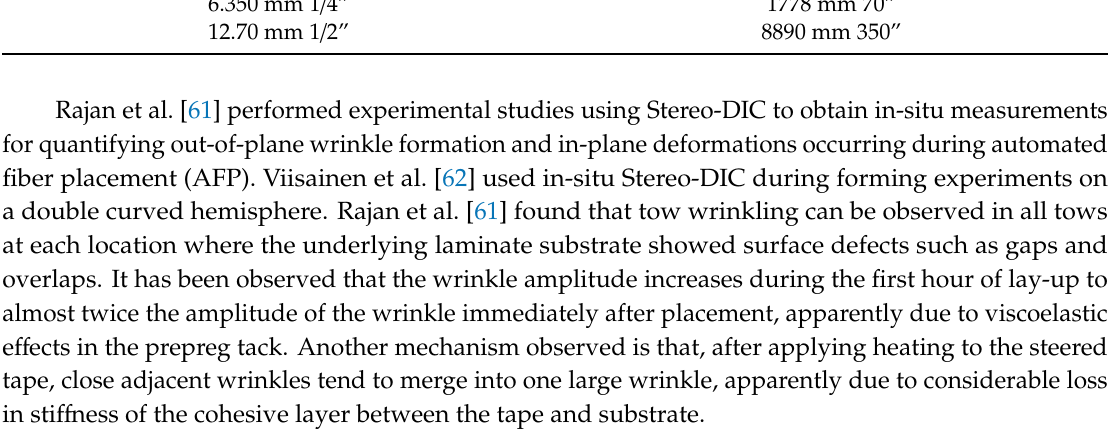
Figure 11. ( a ) Representation of the book-end effect, created when a laminate is consolidated unconstrained over a corner radius and slippage occurs; ( b ) constrained consolidation due to high shear resistance leading to fiber waviness; ( c ) book-end resulting from forming process illustrating the termination angle θ . If layers can shear/slip over one another, the additional length can be accommodated by producing so-called “bookends” [18], which are shown in Figure 11c. However, if the tack between the plies is too high, axial compressive stresses are built up in the layers which may form wrinkles.